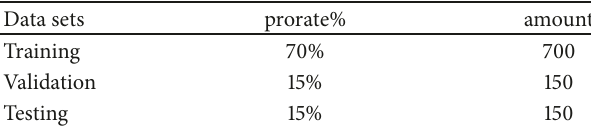
Table 8: Sample set allocation table.